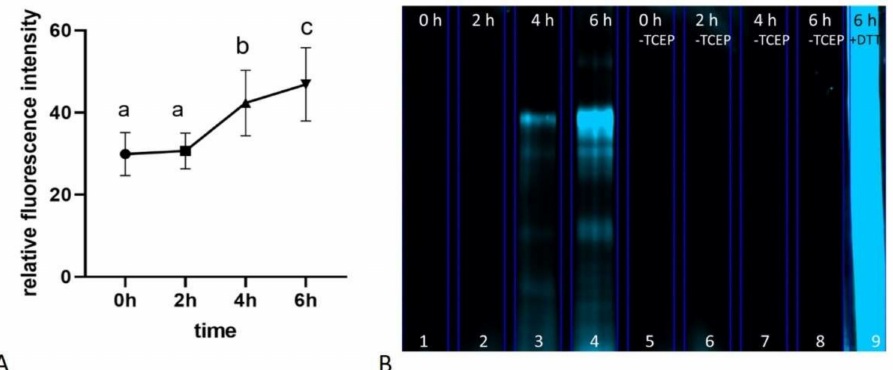
Figure 6. Relative fluorescence intensity corresponding to the levels of reversible oxPTMs of bull sperm incubated for 0, 2, 4 and 6 h under capacitation-supporting conditions. Different letters indicate significant differences ( p < 0.05) among timepoints. Data are expressed as the mean ± SEM ( n = 8) ( A ). Representative polyacrylamide gel showing reversible protein oxPTMs of bull sperm incubated for 0, 2, 4 and 6 h under capacitation-supporting conditions (lines 1–4), negative controls without a protein reduction step with TCEP (lines 5–8) and positive control treated with DTT after protein extraction (line 9) ( B